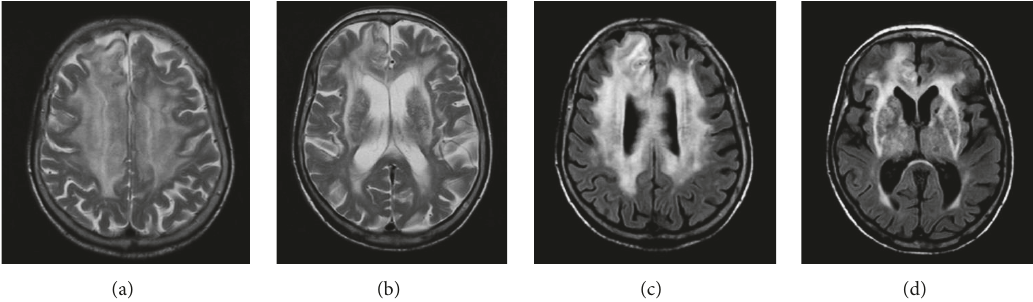
Figure 1: Axial T2 weighted (a, b) and FLAIR (c, d) MR imaging showing extensive white matter hyperintensity signal changes with a confluent pattern in periventricular and deep white matter of the cerebral hemispheres, without vascular distribution, more extensive on the right frontal region and involving all segments of the corpus callosum